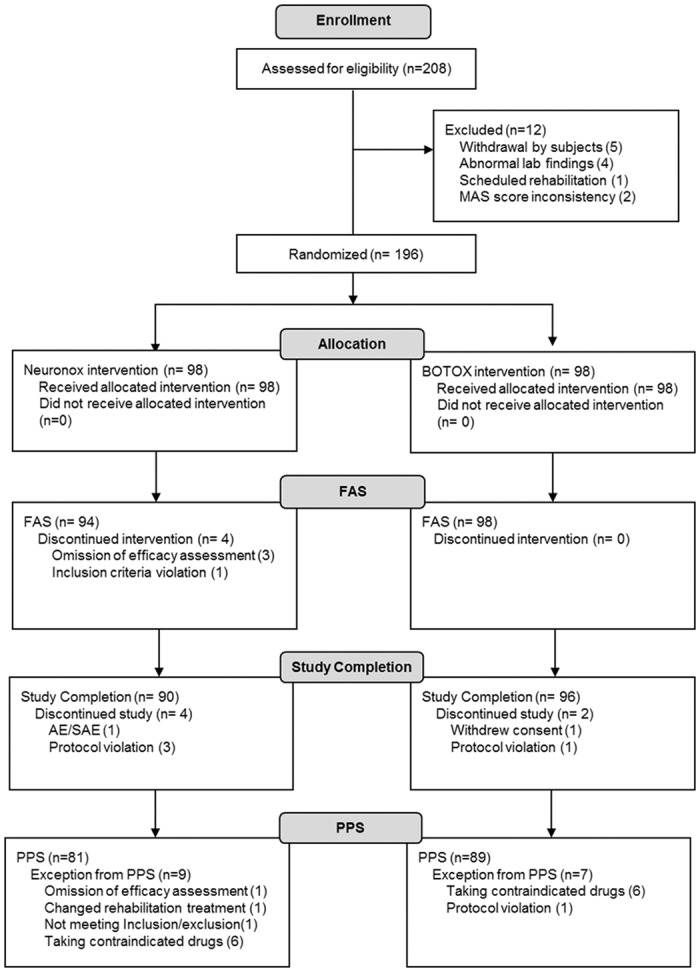
Study flowchart.MAS, Modified Ashworth Scale; FAS, full analysis set; PPS, per-protocol set.